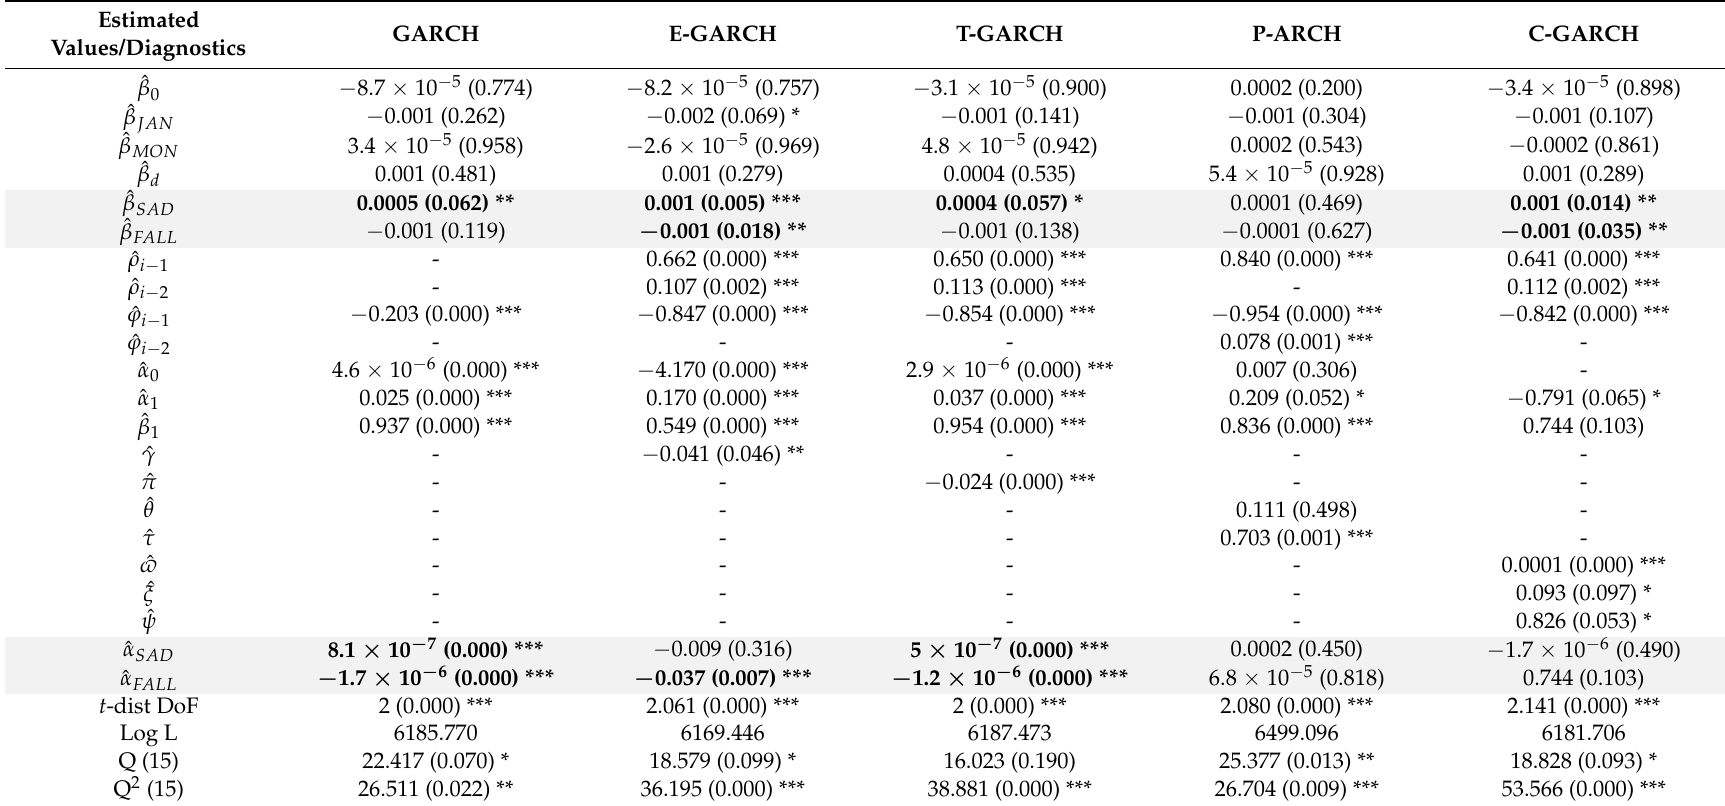
Table A8. Different GARCH specifications for